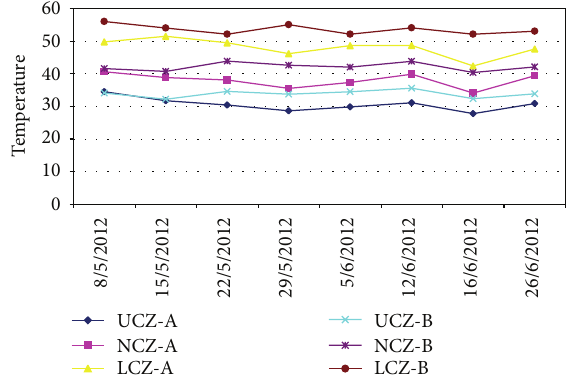
Figure 2: Performance curves of solar ponds “A” and “B”.